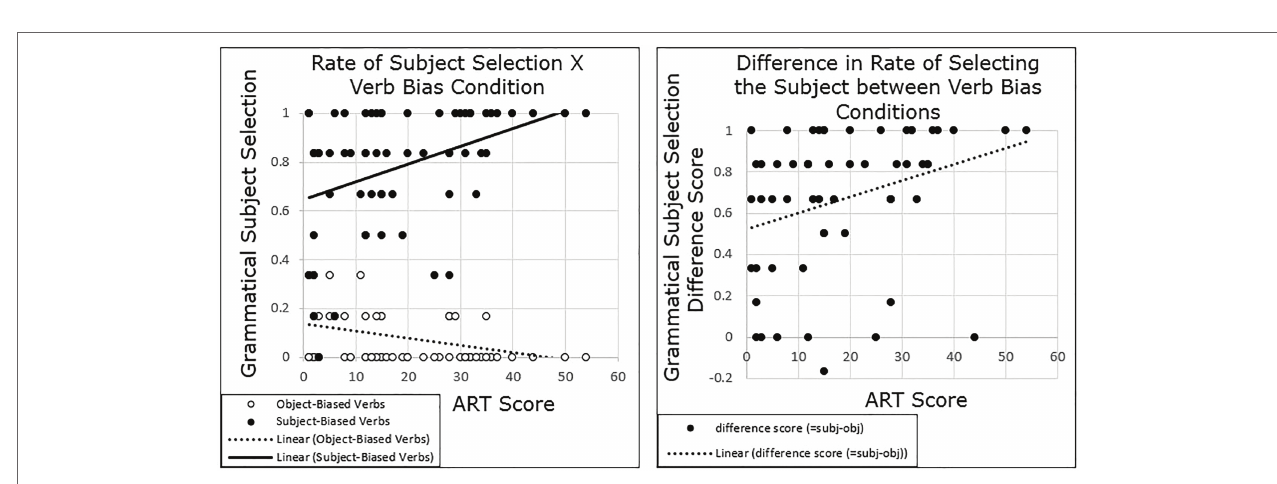
FIGURE 3 | Experiment 2 results: participants with higher ART scores show a stronger semantic bias than those with lower ART